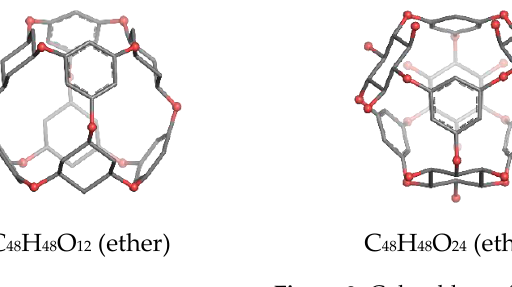
Figure 2. Cube-rbl-core( 4 ) structures.